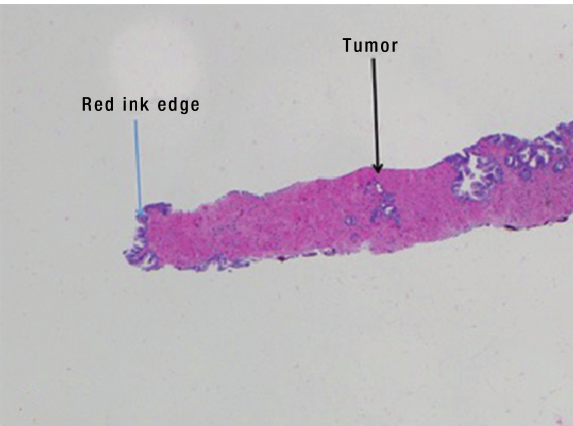
Figure 3 - Relationship of cancer to peripheral margin.